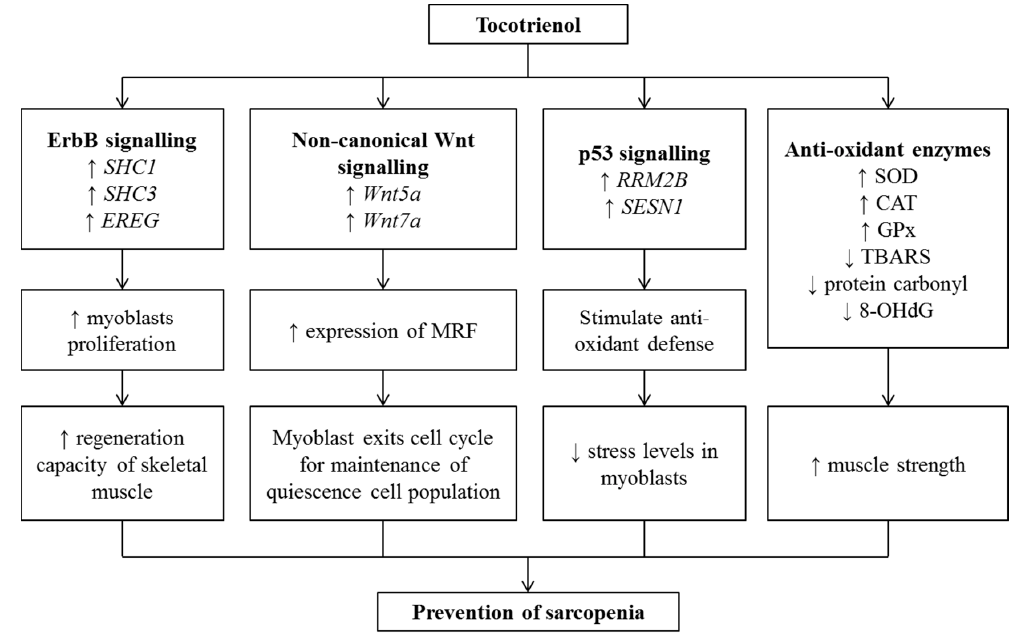
Figure 5. Effects of T3 on muscle health. Figure 5. E ff ects of T3 on muscle